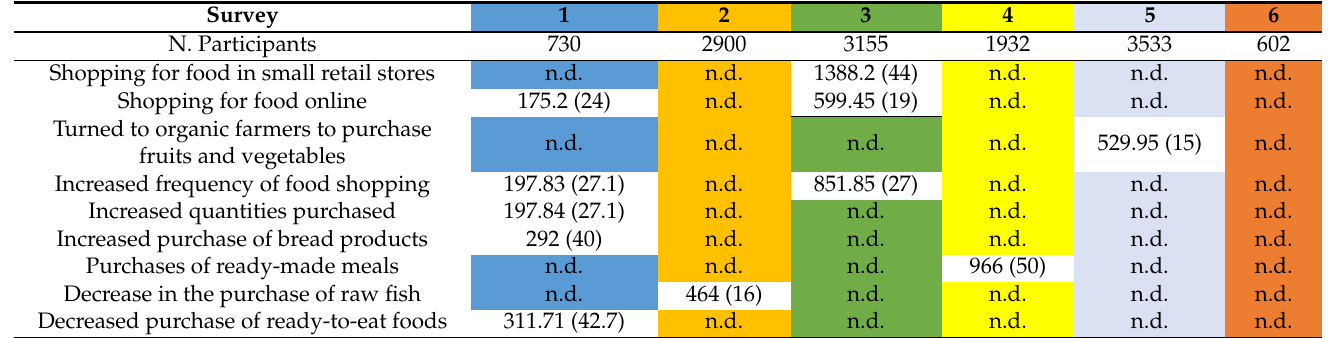
Table 3. Shopping for food, absolute value (N.) and (%) on the total.